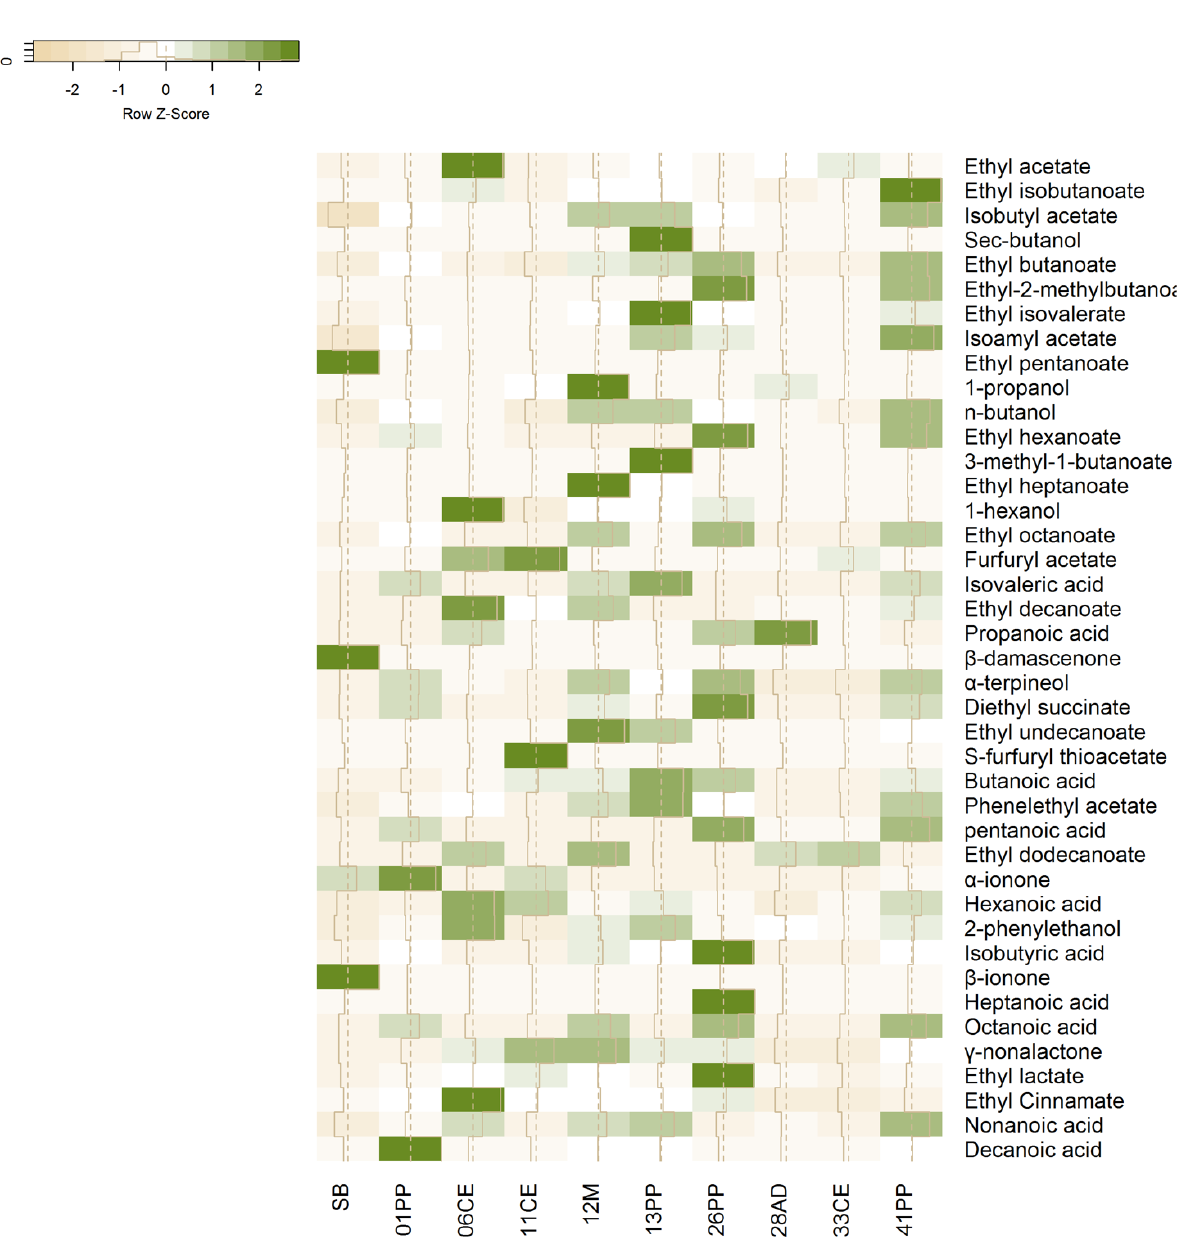
Figure 2. Heatmap generated from the z -scores representing the olfactory activity values of the volatile compounds produced by wild strains 26PP, 41PP, 01PP, 12M, 33CE, 28AD, 13PP, 06 EC, and 11CE and controls (unfermented SB must and commercial strain 2048SC). The values in green and yellow represent high and low olfactory activities, respectively; white represents no change in the aroma perception of the volatile compounds.